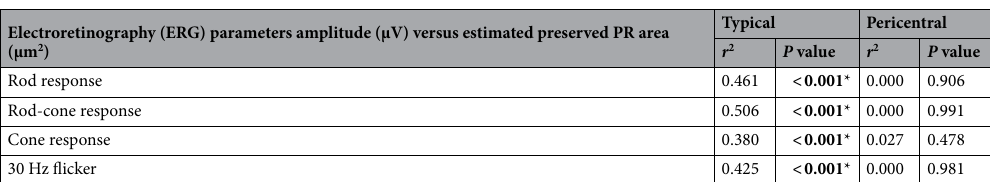
Table 2. Linear regression between electroretinography (ERG) parameters amplitude and estimated preserved PR area. * p <